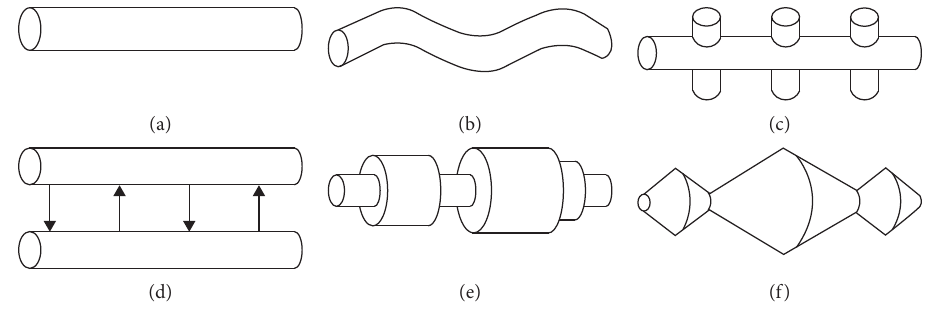
Figure 2: The simplest capillary models of porous bodies [39]: (a) a straight channel; (b) sinuous channel; (c) a channel with departing deadlock pores; (d) a system of parallel channels with an ideal connection; (e) serial model; (f) periodic corrugated